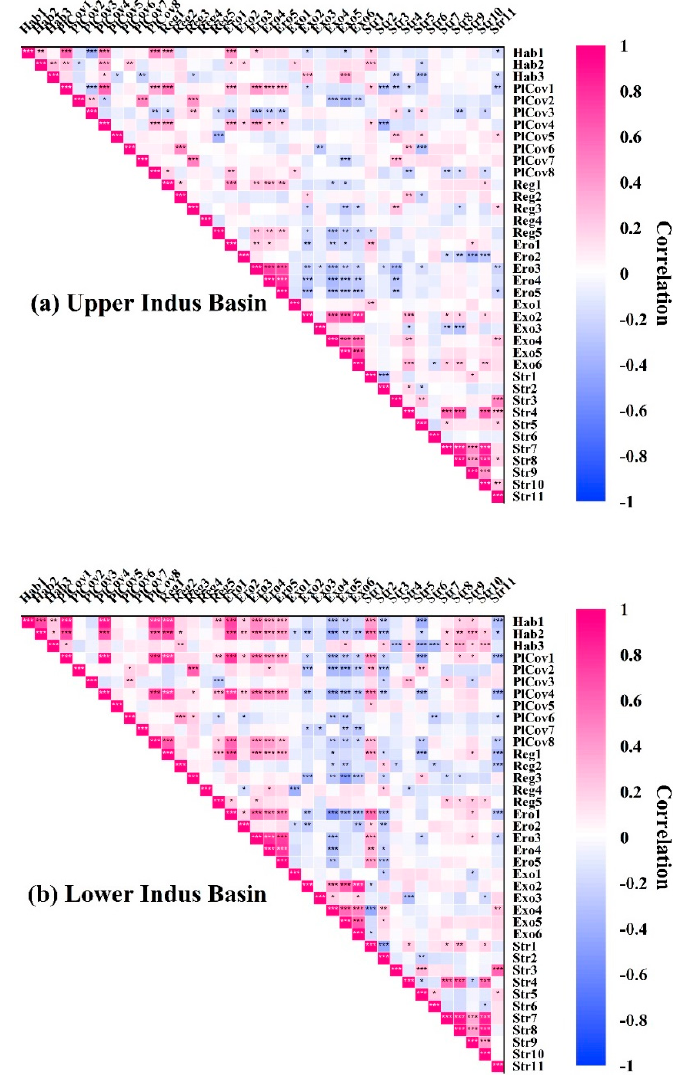
Figure 5. Heat maps of Pearson’s correlation for riparian health indicators with stressors for the upper ( a ) and lower ( b ) Indus basin riparian zones of the Indus River in Pakistan. A dark color indicates a strong relationship, whereas a light color represents a weak relationship. *** Correlation is significant at the 0.001 level (two-tailed); ** Correlation is significant at the 0.01 level (two-tailed); * Correlation is significant at the 0.05 level (two-tailed). See more details in Figure 2.